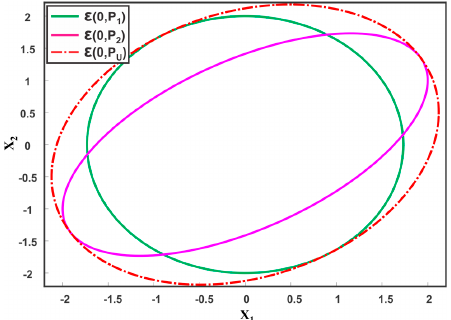
Figure 14. Illustration of two ellipsoids ε ( 0,P 1 ) , ε ( 0,P 2 ) and their consistent fused result ε ( 0,P U ) , provided by the CU method. Table 3. Overview of the methodologies for inconsistent and spurious data sources.